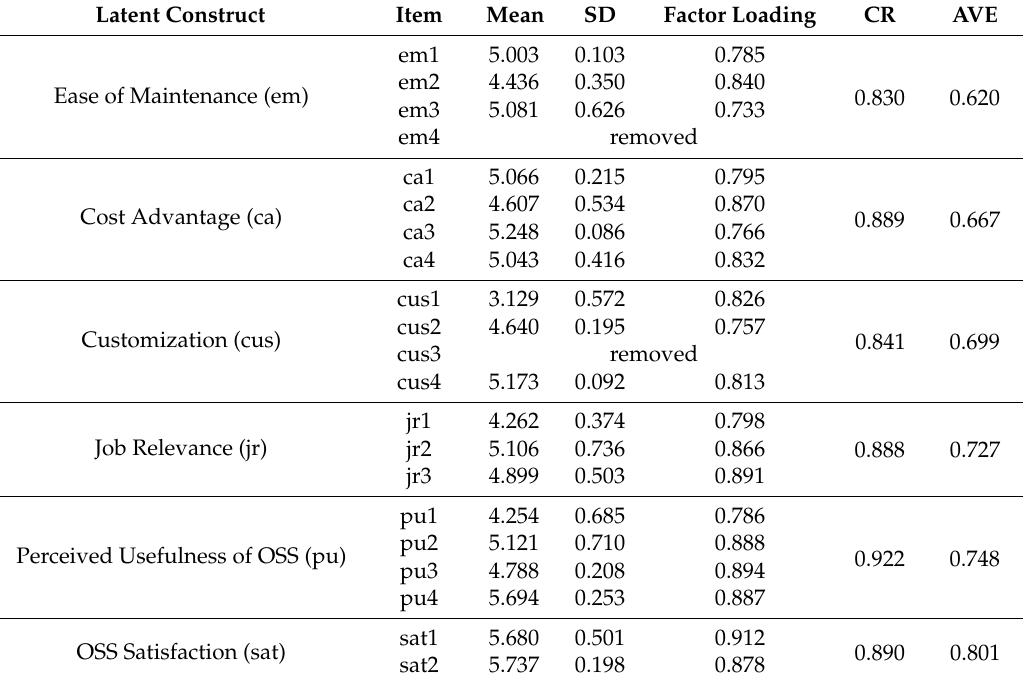
Table 5. Results of convergent validity.